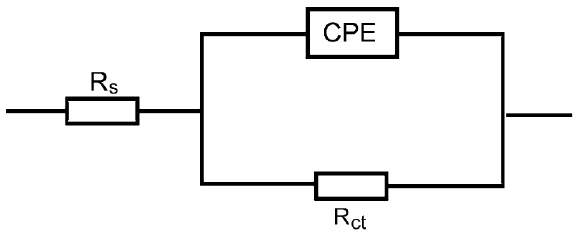
Figure 6. Plots pf: (a) Nyquist, (b) Bode magnitude, and (c) Bode phase for mild steel in 0.5 M HCl solution at 303 K in absence and presence of amylopectin.